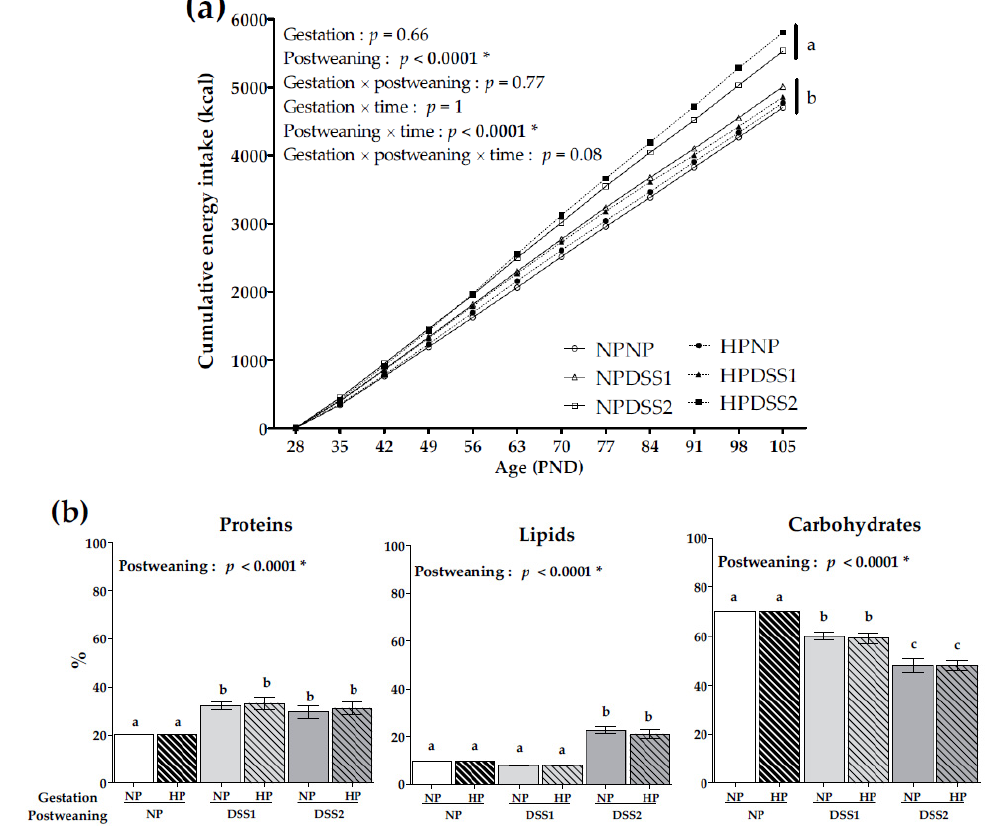
Figure 2. Cumulative energy intake during self-selection period from PND28 to PND105 ( a ) and macronutrient (Proteins, Lipids and Carbohydrates) consumption levels (% of total energy intake) on PND105 ( b ). Data are means ± SEMs. Effects of diets were tested within model W and Wt (*, p < 0.05). Means that are significantly different ( p < 0.05) according to the post-hoc test have different letters ( a or b or c ). PND, Post-natal Day; NP, Normal-Protein (control); HP, High-Protein; DSS1, Dietary Self-Selection 1 (P and G/L in 2 different cups); DSS2, Dietary Self-Selection 2 (P, G and L in 3 different cups).